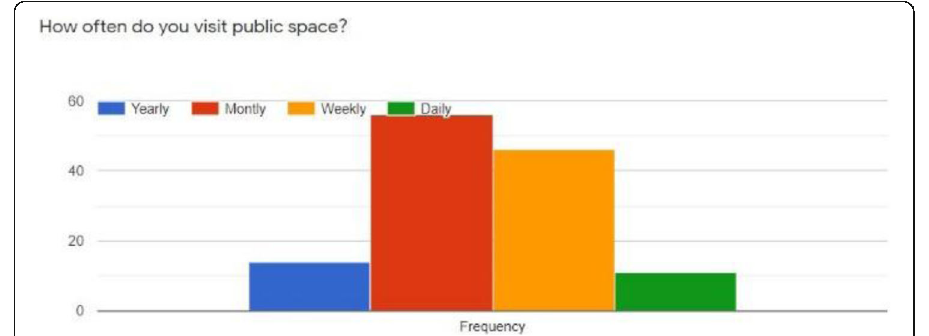
Fig. 14 How often to visit public spaces